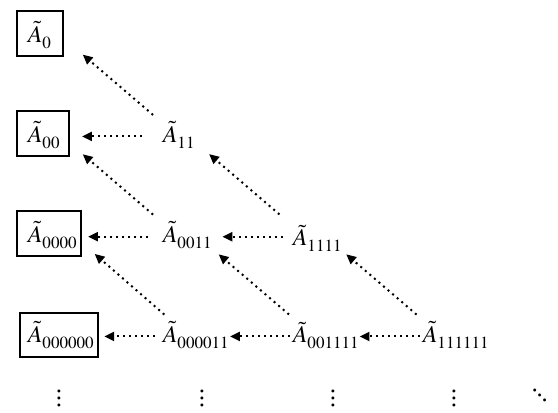
Figure 1 . Schematic roadmap for PV reduction of one-point FVC tensor integrals. The dashed lines with arrows represent simplification operations by the recursive use of eq. (3.8). The coefficients on the left, enclosed in the boxes, are regarded as tensor